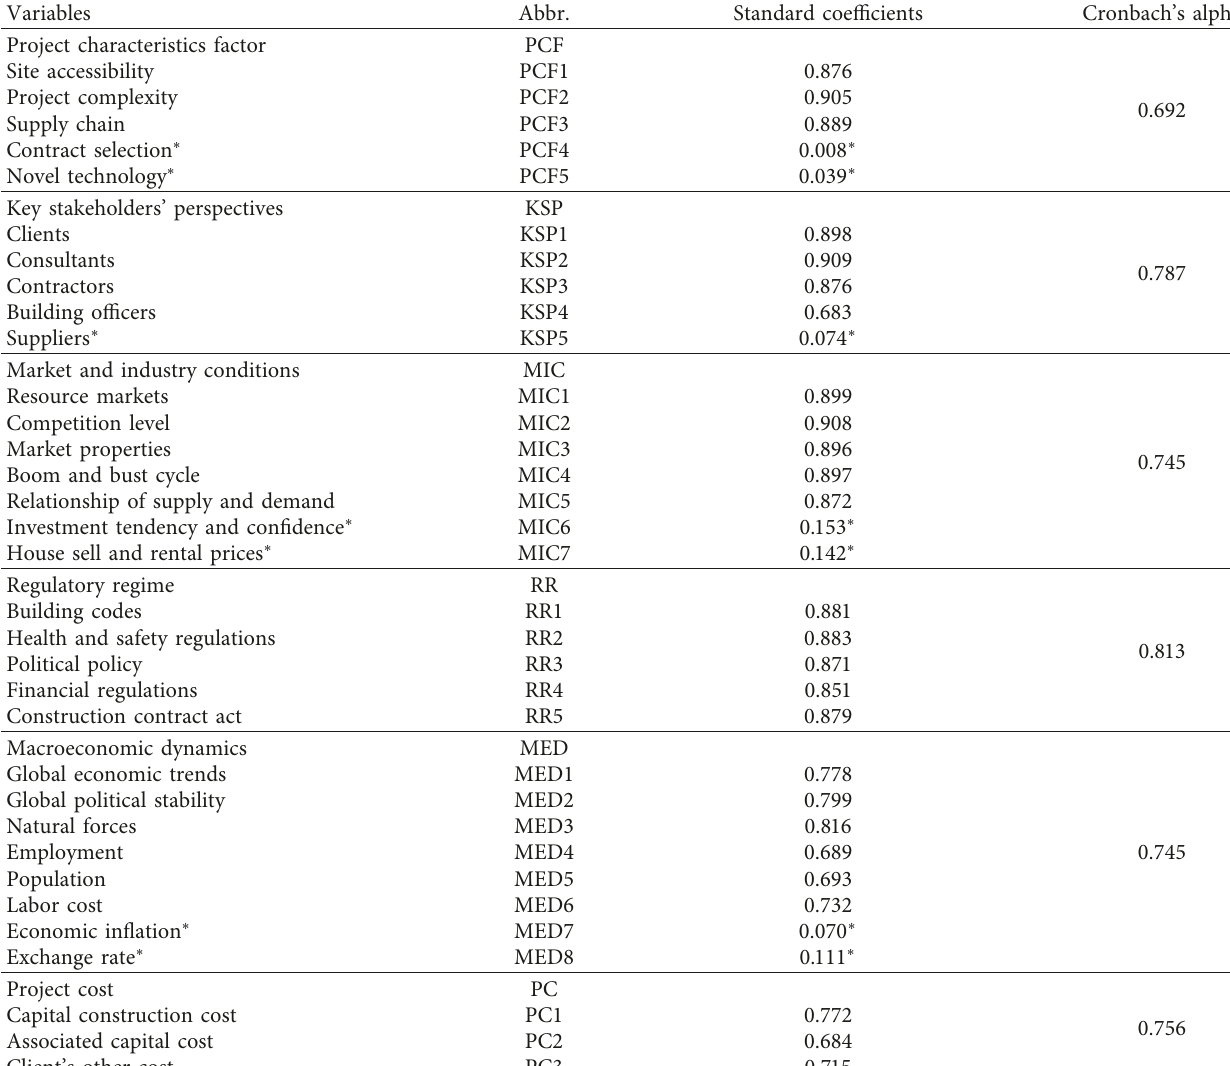
Table 3: Measurement model results and reliability test